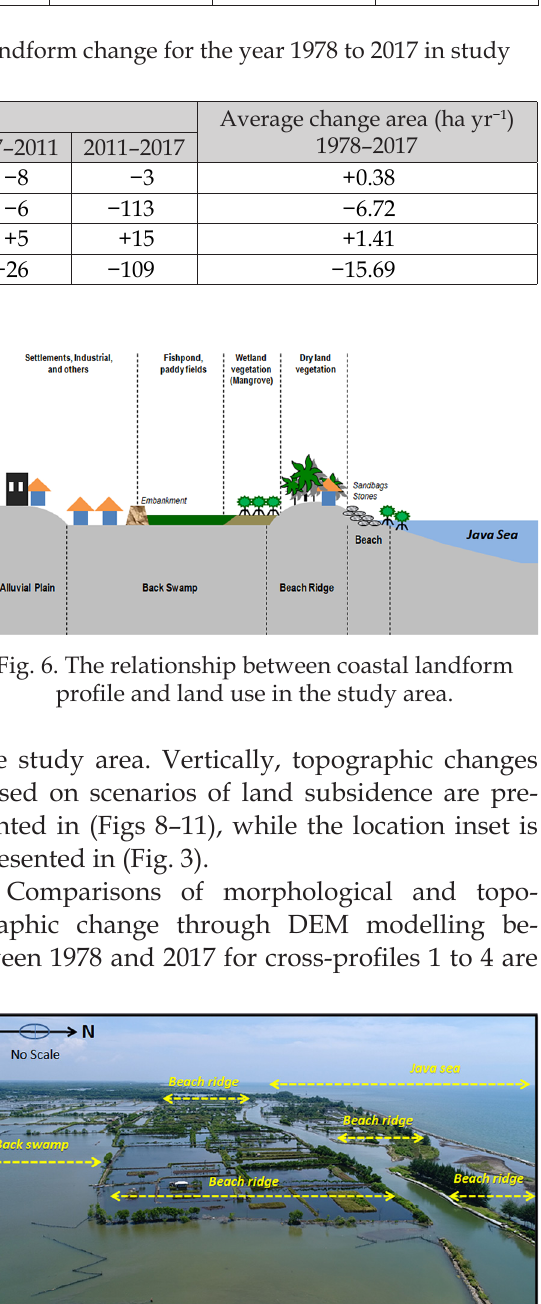
Fig. 7. Landform coastal conditions in 2017 in the study area. The beach ridge, which has an important role as a natural embankment in coastal areas, has been changed into a flat area and is used by local people for ponds (Photo: F. Yulianto 2017).